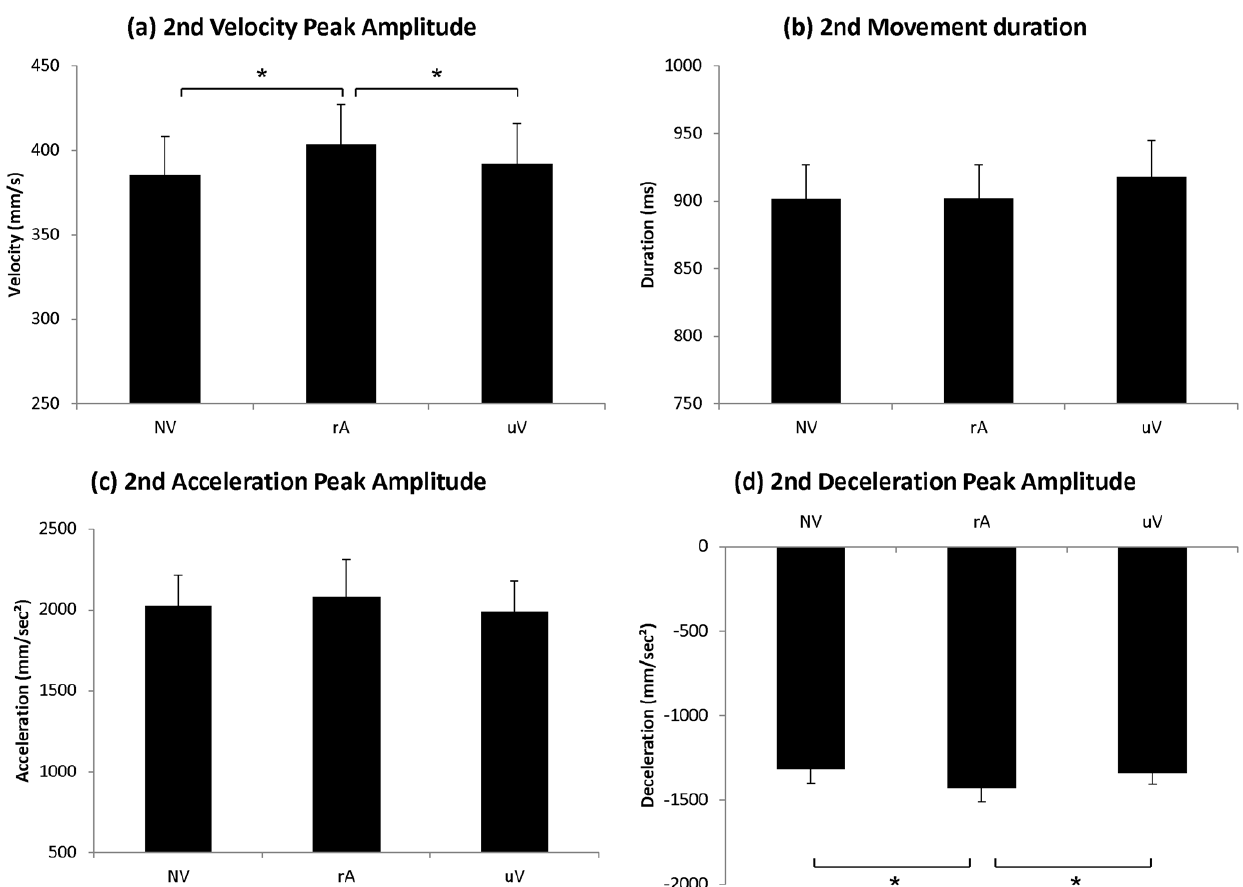
Figure 4. Experiment I: Kinematic parameters of the ‘‘Lift-to-Displace’’ movement. Mean values of (a) wrist velocity peak amplitude and (b) movement duration (c) wrist acceleration peak amplitude and (d) wrist deceleration peak amplitude. Error bars represent standard error of the mean (SEM). *p , 0.05.